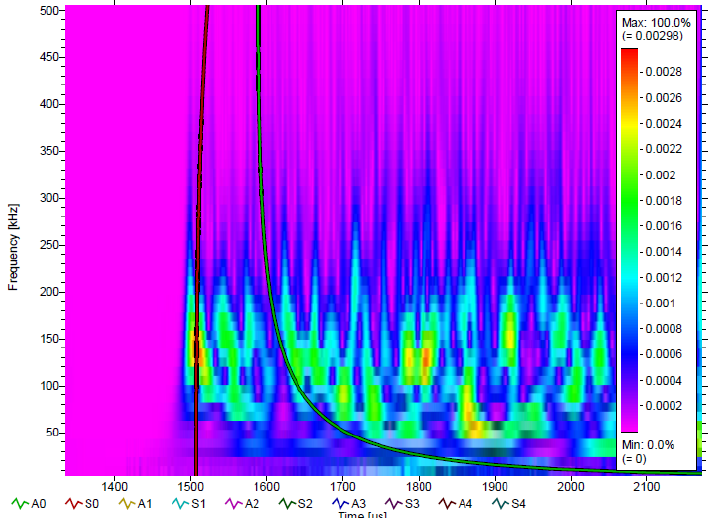
Figure 12. Wavelet transforming diagram of the experimental signal, velocity = 3.97